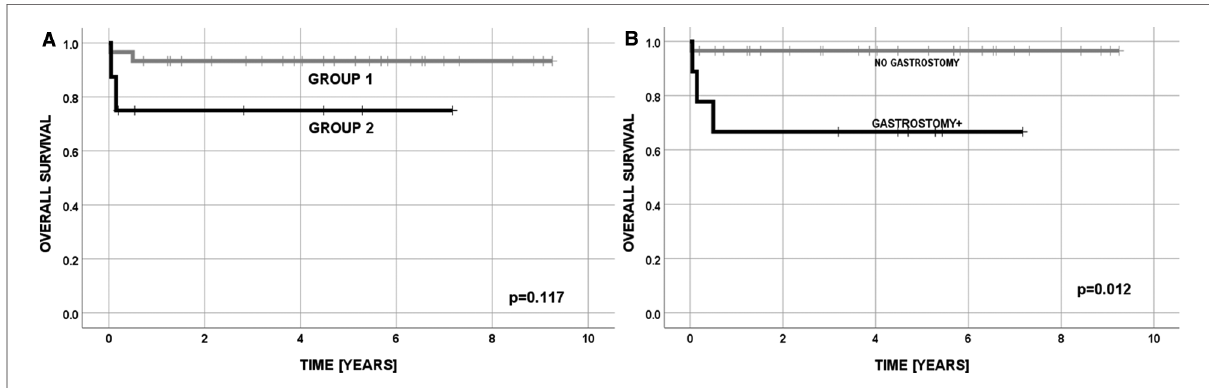
FIGURE 2 Overall survival: ( A ) in Group 1 and 2; ( B ) with respect to gastrostomy.